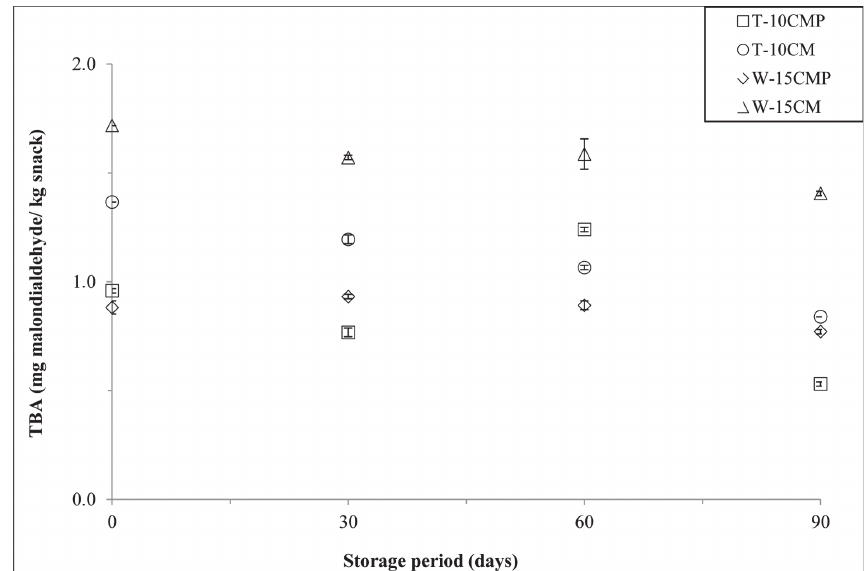
Figure 5 - TBA values of enriched snacks.